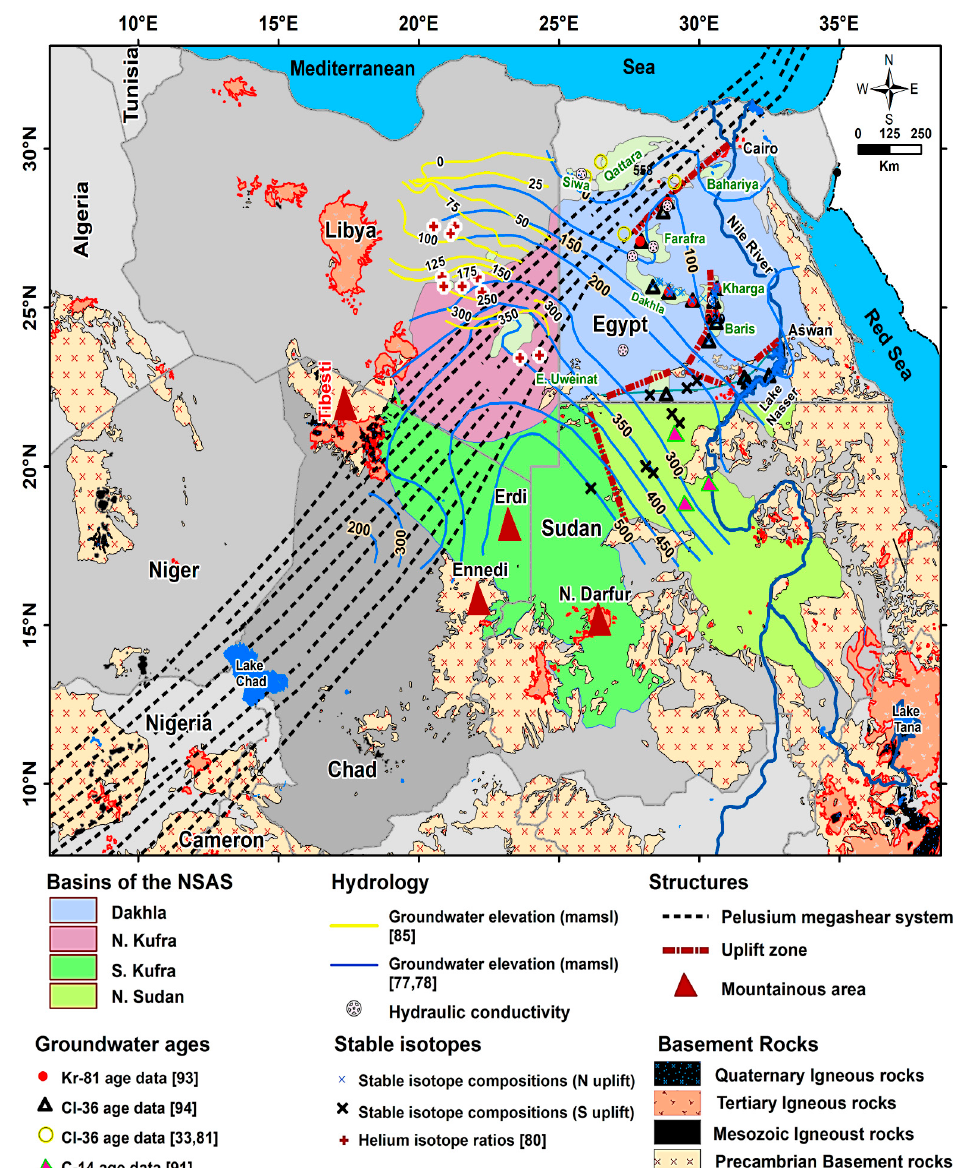
Figure 14. The distribution of the Pelusium megashear, the Uweinat-Aswan and Uweinat-Howar basement uplifts, the Kufra, Dakhla, and Northern Sudan Platform basins of the NSAS are all highlighted. Additionally, it shows the locations of groundwater samples that were located south and north of the Uweinat-Aswan uplift and were isotopically analysed (O, H) and dated (Kr-81; Cl-36; and C-14) in the aquifer.